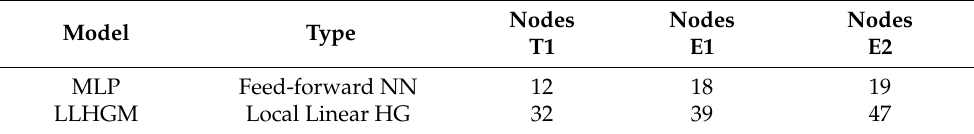
Table 4. Structure of the compared models.